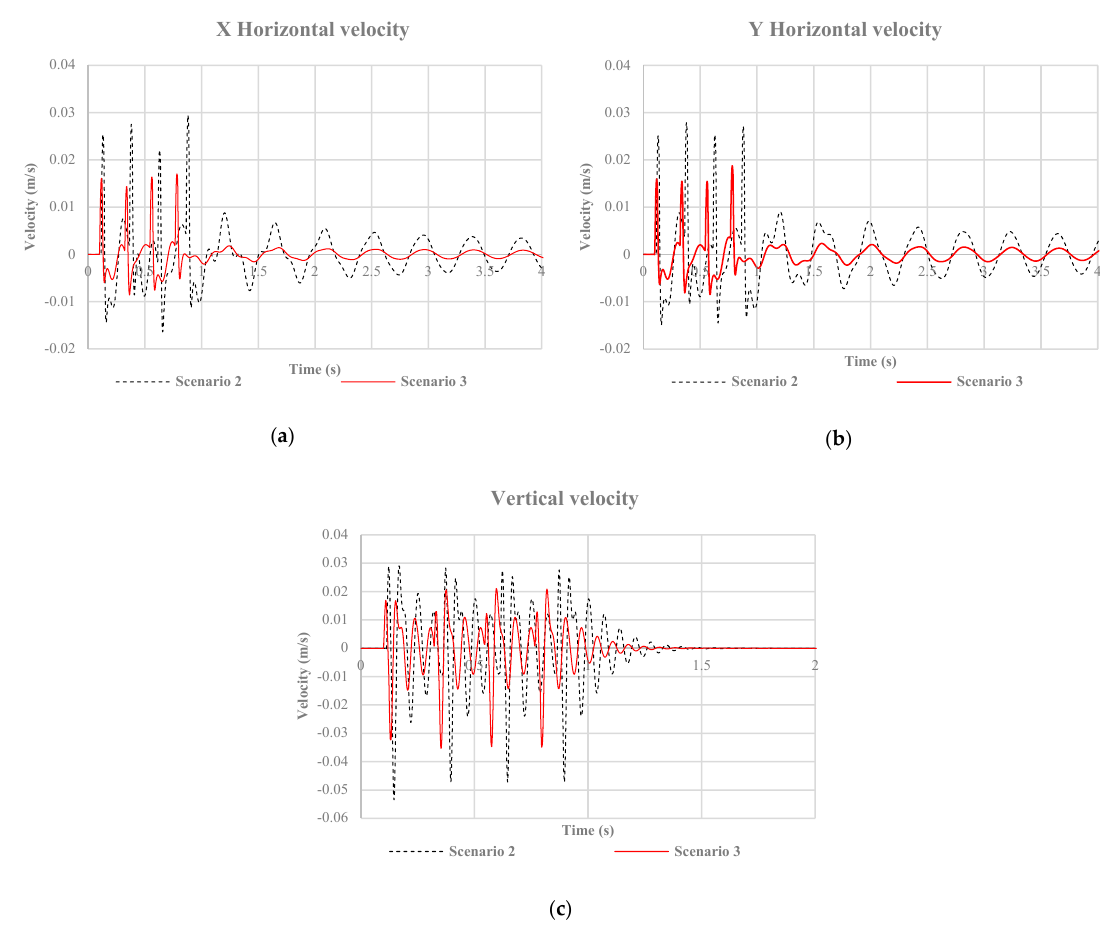
Figure 10. Comparison between the two excavation techniques in terms of ( a ) horizontal velocity in the x direction ( b ) horizontal velocity in the y direction ( c ) vertical velocity of the control point.